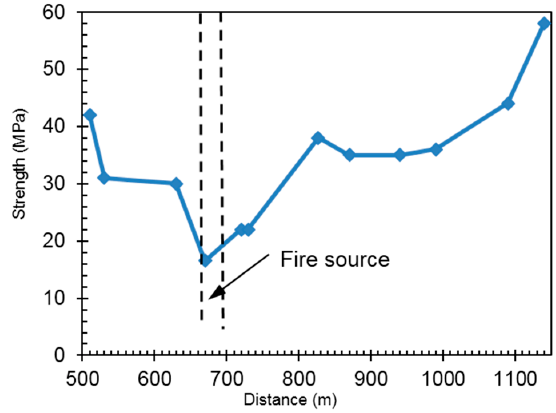
Figure 3. Longitudinal distribution diagram of vault concrete strength along the tunnel.